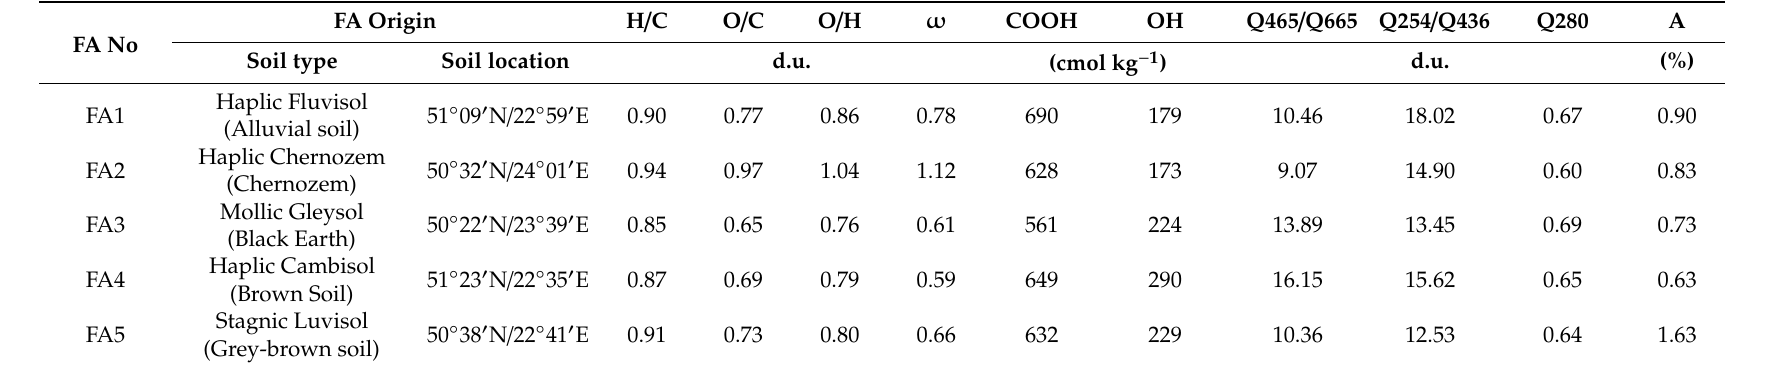
Table 1. Chemical and structural properties of soil fulvic acids